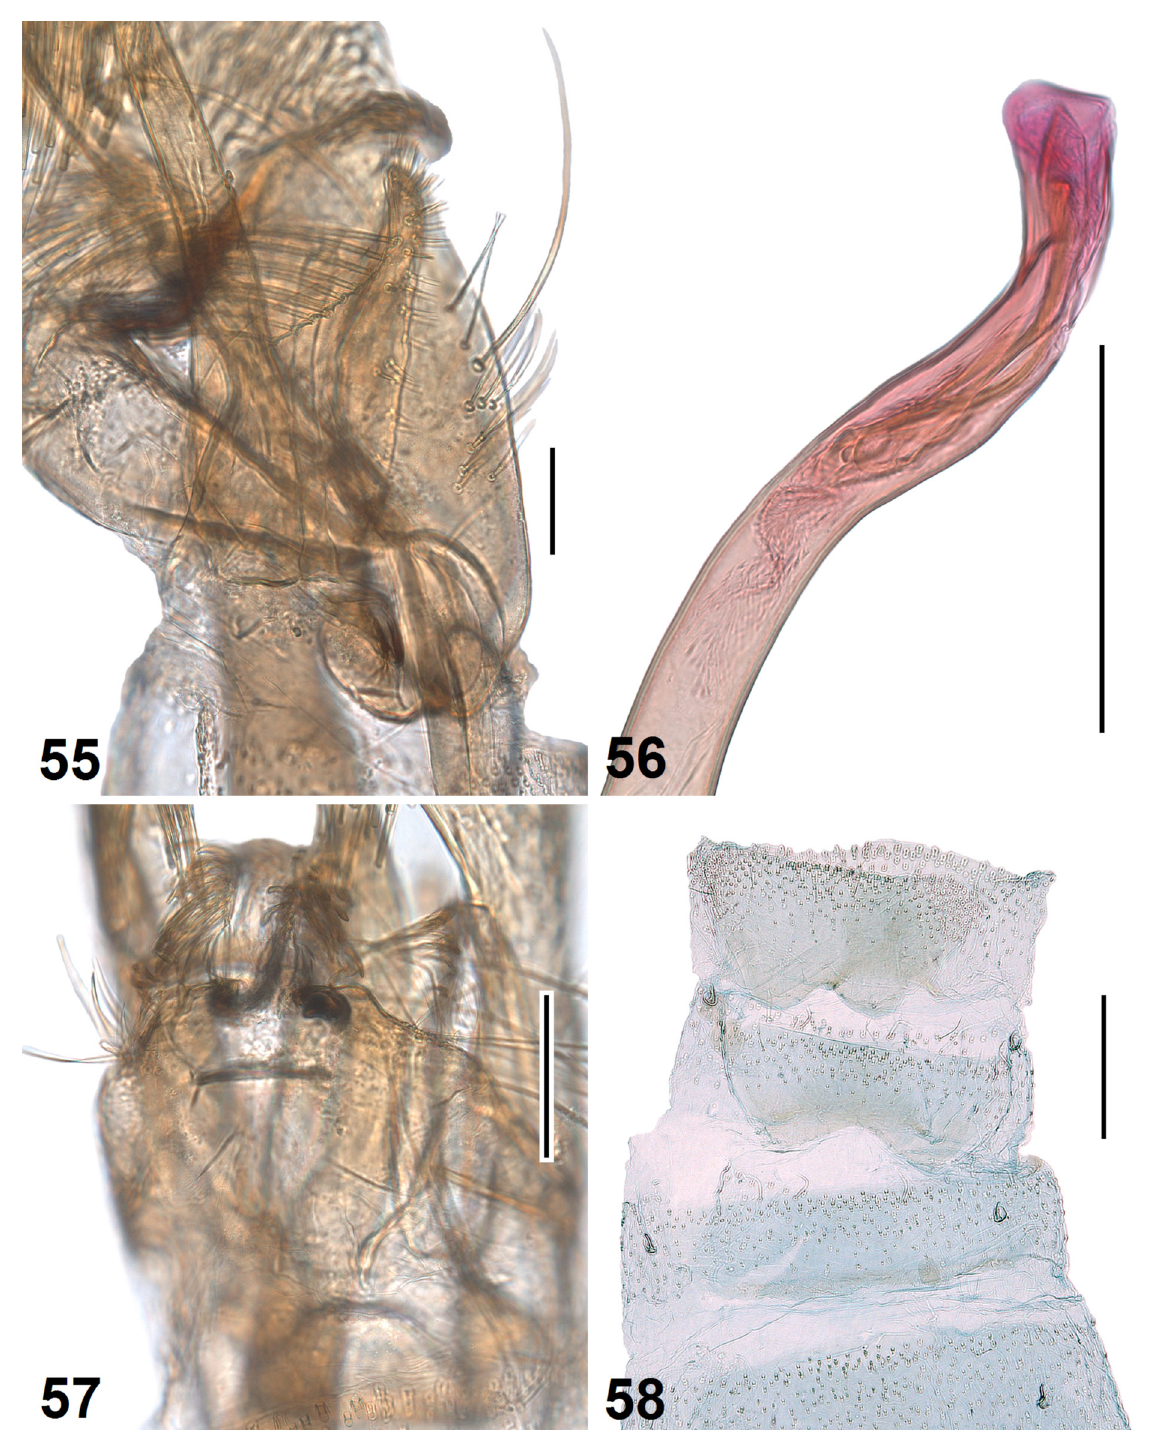
Figs 55–58. Elachista phichaiensis Sruoga & Kaila sp. nov., male genitalia, holotype, ♂ (MZH VS3/2.11.18, in glycerol before permanent mounting in Euparal). 55 . Juxta, lateral view. 56 . Distal part of phallus. 57 . Uncus lobes, dorsal view. 58 . Distal part of abdomen. Scale bars = 0.1